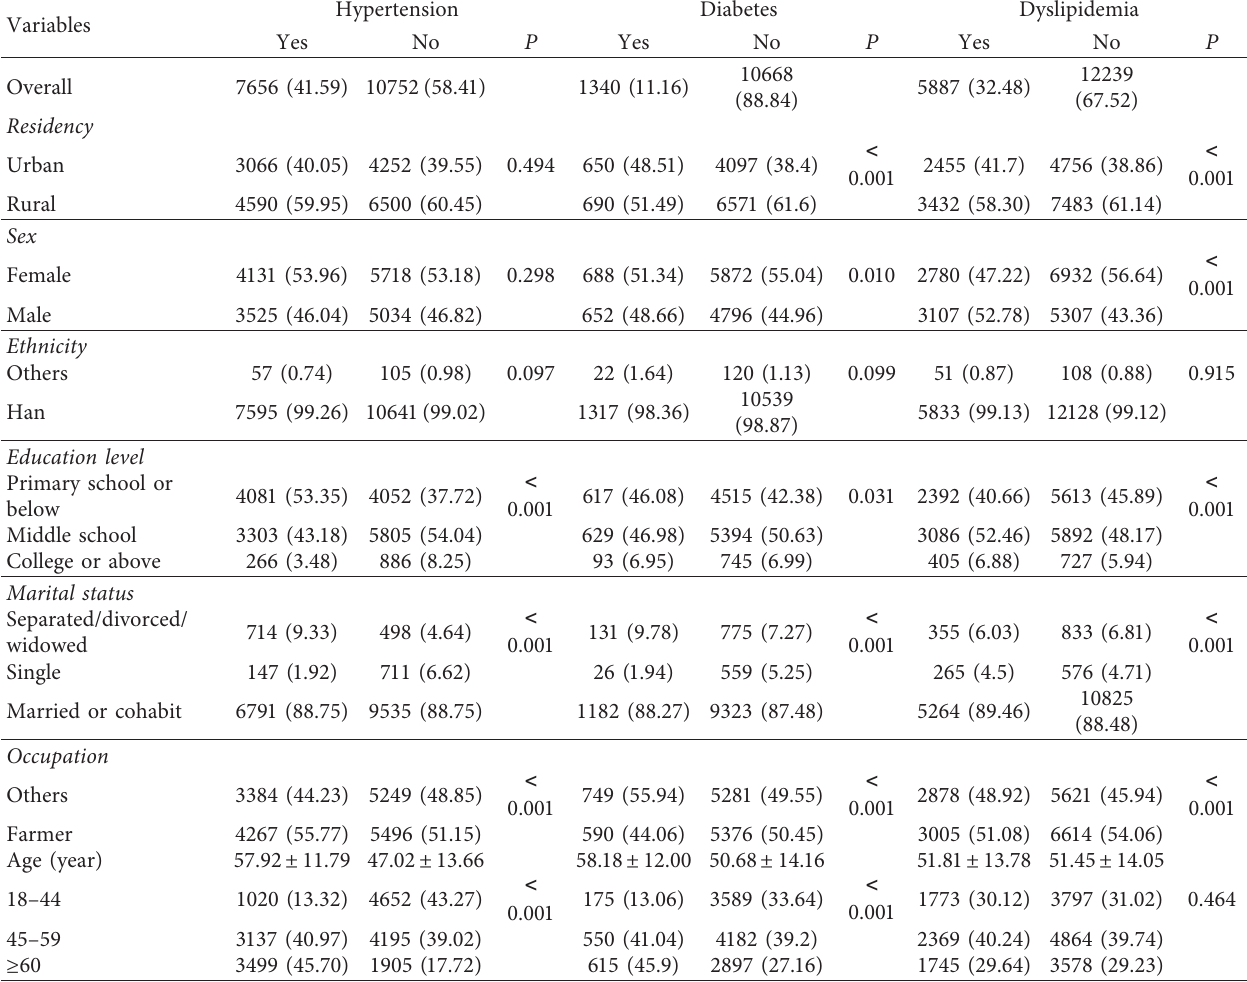
Table 2: Baseline of the participants in northwest